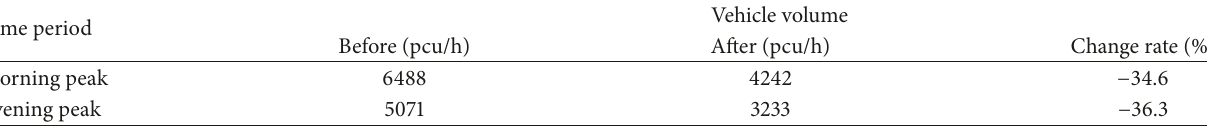
Table 1: Changes in vehicle volume after bus lane set in Jing-Tong expressway